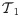
The transformation T1 in the proof of Proposition 25.